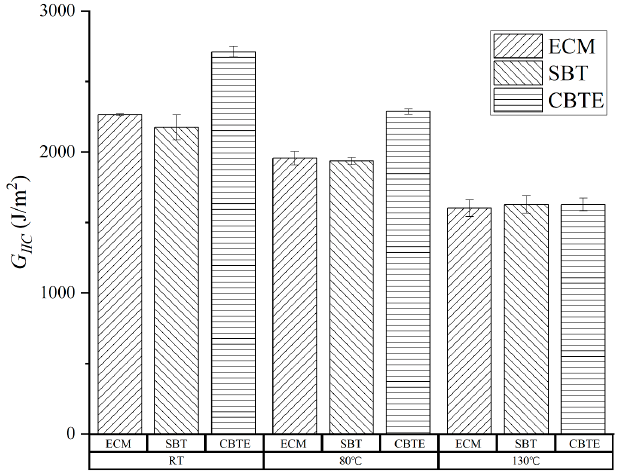
Figure 5. Comparison of mode II fracture toughness calculated by different data reduction methods. Table 2. Mode II fracture toughness of ENF specimens evaluated at different temperatures. (Unit: J/m 2 ).